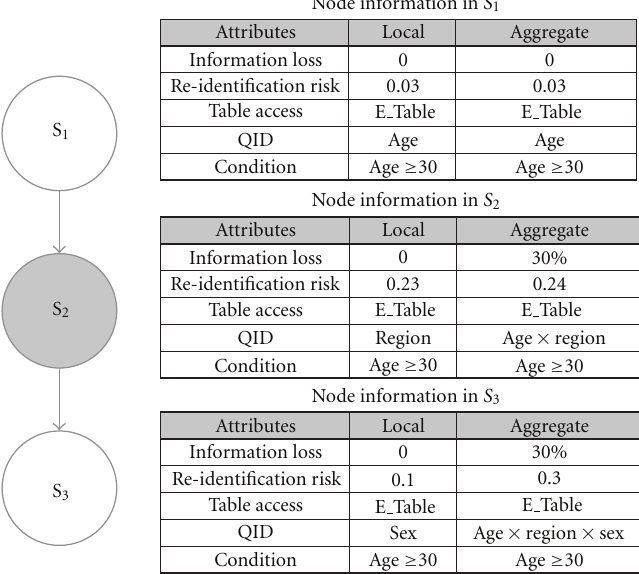
Figure 3: Privacy Tailor